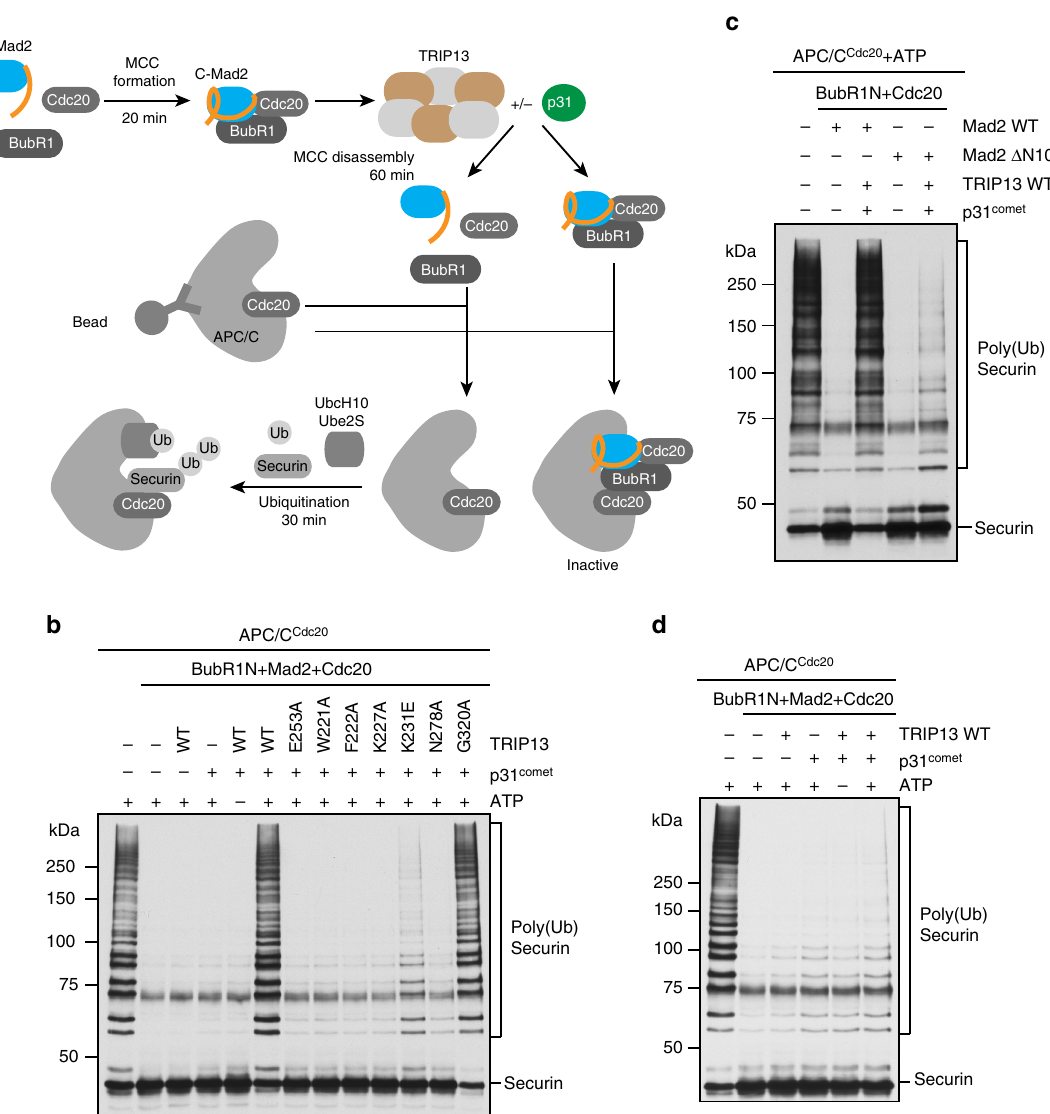
Fig. 7 TRIP13 prevents APC/C Cdc20 inhibition by MCC components. a Schematic diagram of the APC/C ubiquitination assay in the absence or presence of MCC components, TRIP13, or p31 comet . b Ubiquitination of securin-Myc by APC/C Cdc20 in the presence of MCC components (780 nM BubR1N, 1 μ M Mad2, and 600 nM Cdc20), TRIP13 wild type (WT) or the indicated mutants (50 nM), and Δ N35-p31 comet (1 µ M). MCC components were pre-incubated with TRIP13, p31 comet , and ATP (1 mM). The protein mixture was then added to APC/C Cdc20 . The ubiquitination reaction mixtures were blotted with the anti-Myc antibody. c Same as in b except that Mad2 Δ N10 and only TRIP13 WT were used. d Ubiquitination of securin-Myc by APC/C Cdc20 that was fi rst incubated with MCC components (780 nM BubR1N, 1 μ M Mad2, and 600 nM Cdc20) for 20 min and then incubated with TRIP13 WT (50 nM) and Δ N35- p31 comet (1 µ M). The ubiquitination reaction mixtures were blotted with the anti-Myc